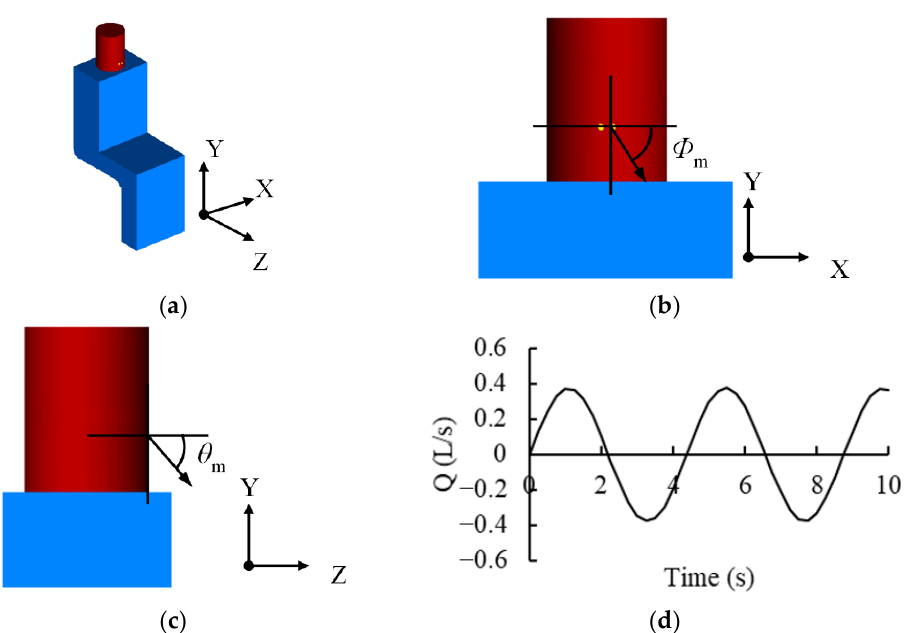
Figure 3. Model for breathing simulation: ( a ) geometric model of the manikin, ( b ) front view of the manikin head, ( c ) side view of the manikin head, ( d ) breathing cycle.